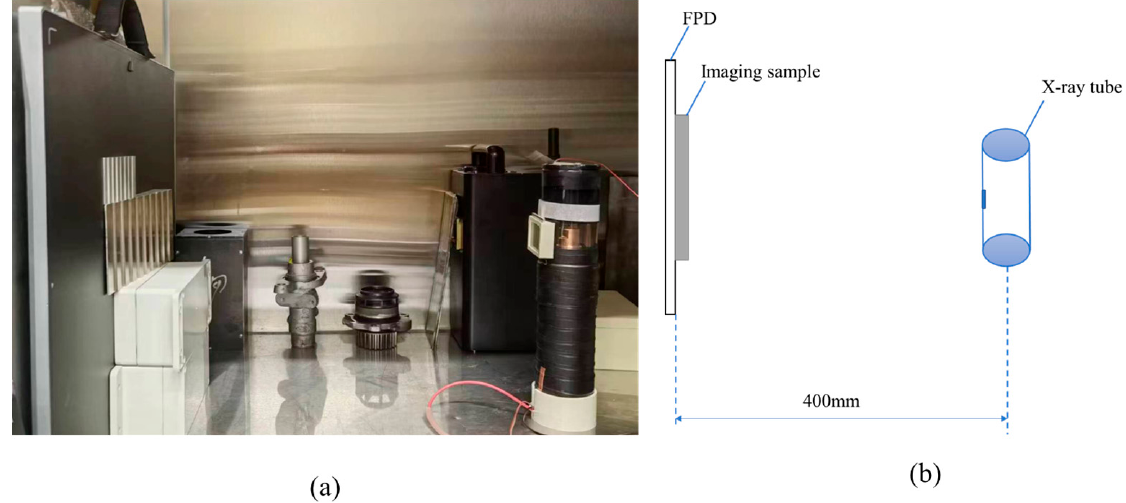
Figure 1. ( a ) X-ray imaging equipment, and ( b ) geometric location diagram of the equipment.